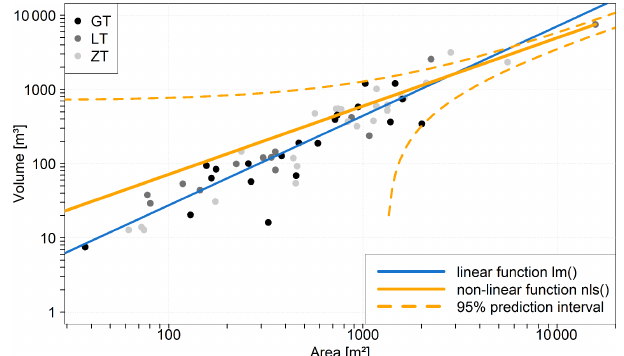
Figure 7. Relationship between area and volume of debris flow de- posits in GT, LT and ZT. The 95% prediction interval of the model calculated by the non-linear method is shown with the dashed